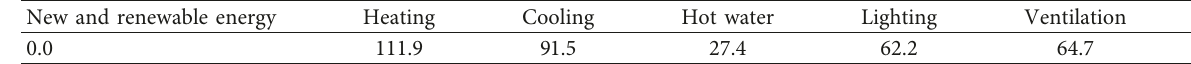
Table 7: Results of the primary energy use (kWh/m 2